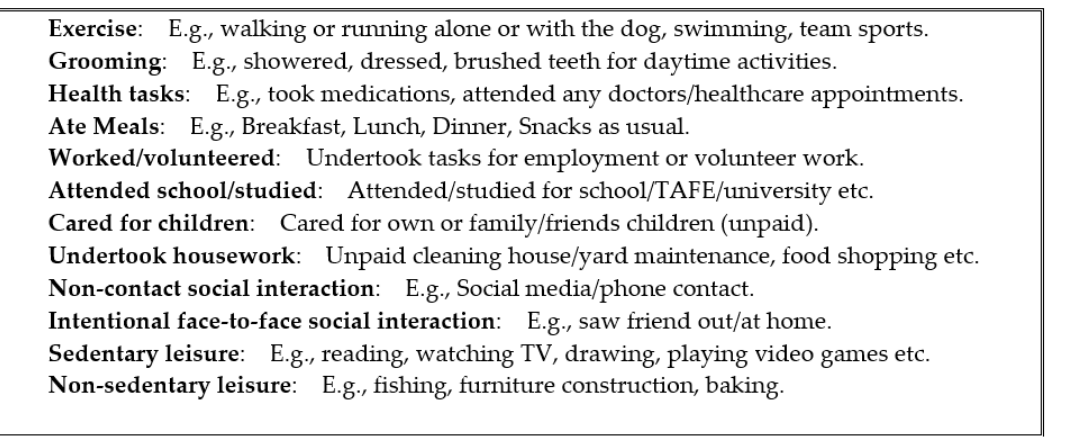
Figure 1. Daytime activity options and examples from the Sleep Impact on Activity Diary (SIAD).